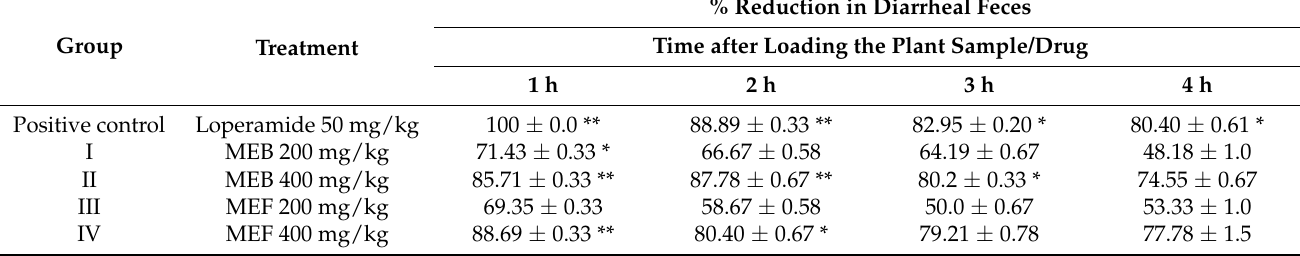
Table 2. Anti-diarrheal effects in terms of % reduction of diarrheal feces following administrating the methanolic extract of bark (MEB) and methanolic extract of fruit (MEF) of W. coccinea in castor oil-induced diarrheal mice model.